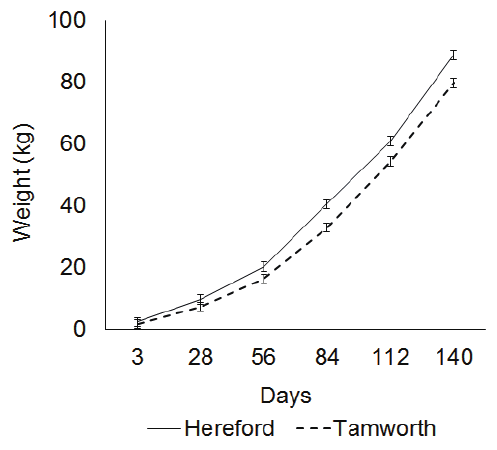
Figure 2. Least square means and standard errors of body weights of Berkshire pigs sired by Hereford and